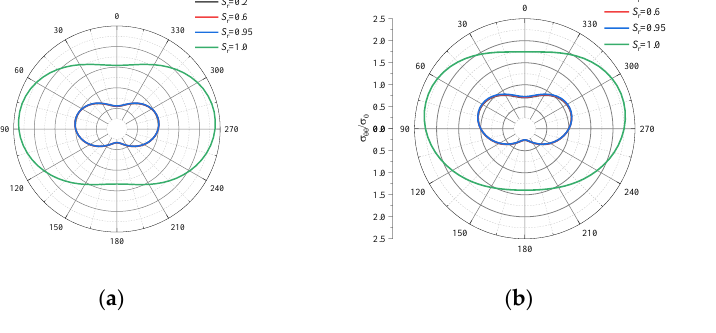
  around the surface of the cavity for P 1 /  0